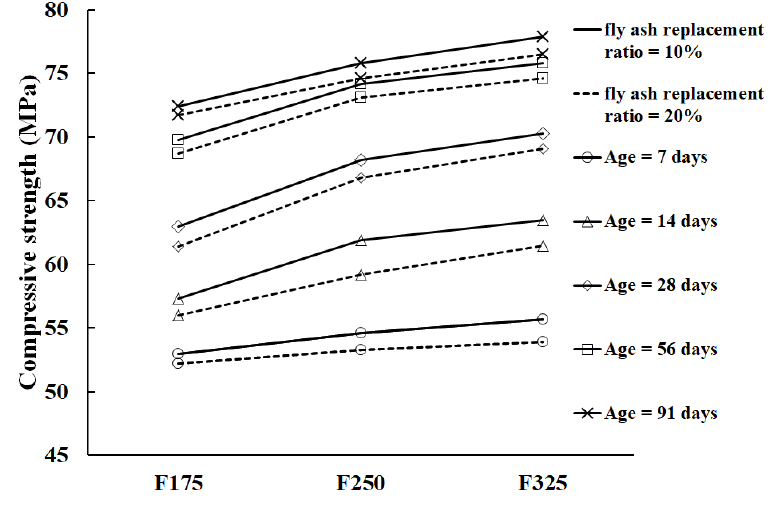
Figure 4. Compressive strength of fly ash concrete versus the particle size of fly ash.